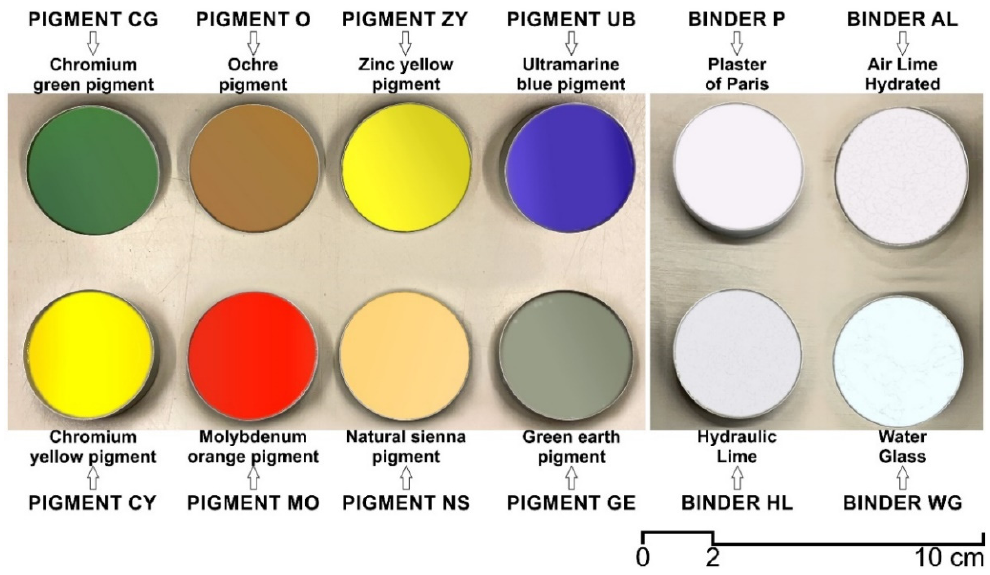
Figure 2. Samples of pigments and binders used in the research.